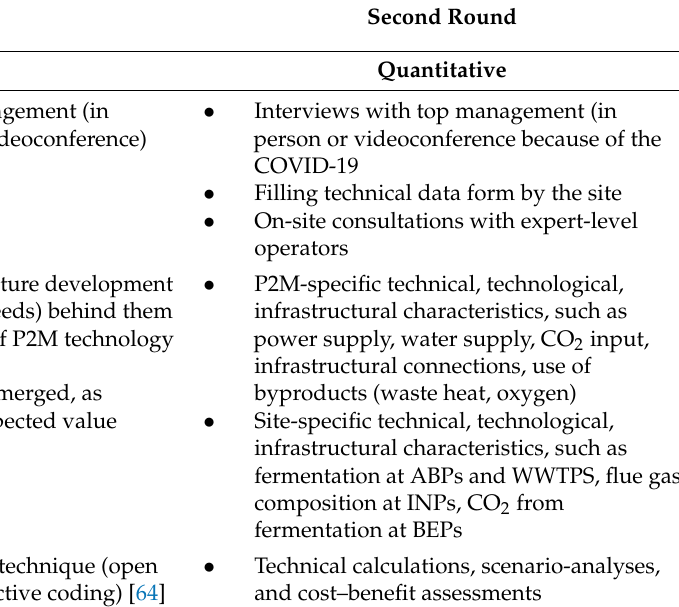
Table 2. Data collection and data analysis of the